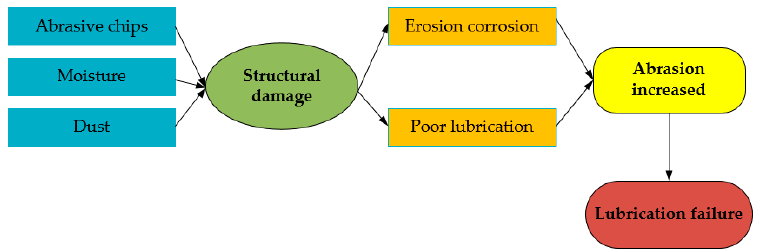
Figure 11. Contaminant factors of lubrication failure [104,106].